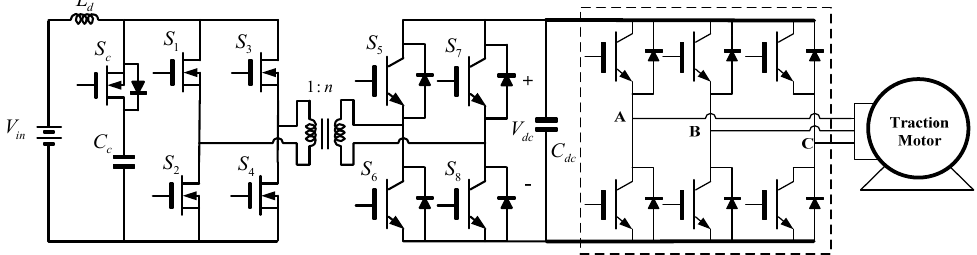
Figure 8. Bidirectional DC–DC converter with full–bridge current source converter for LV side and full–bridge voltage source converter for HV side [15].